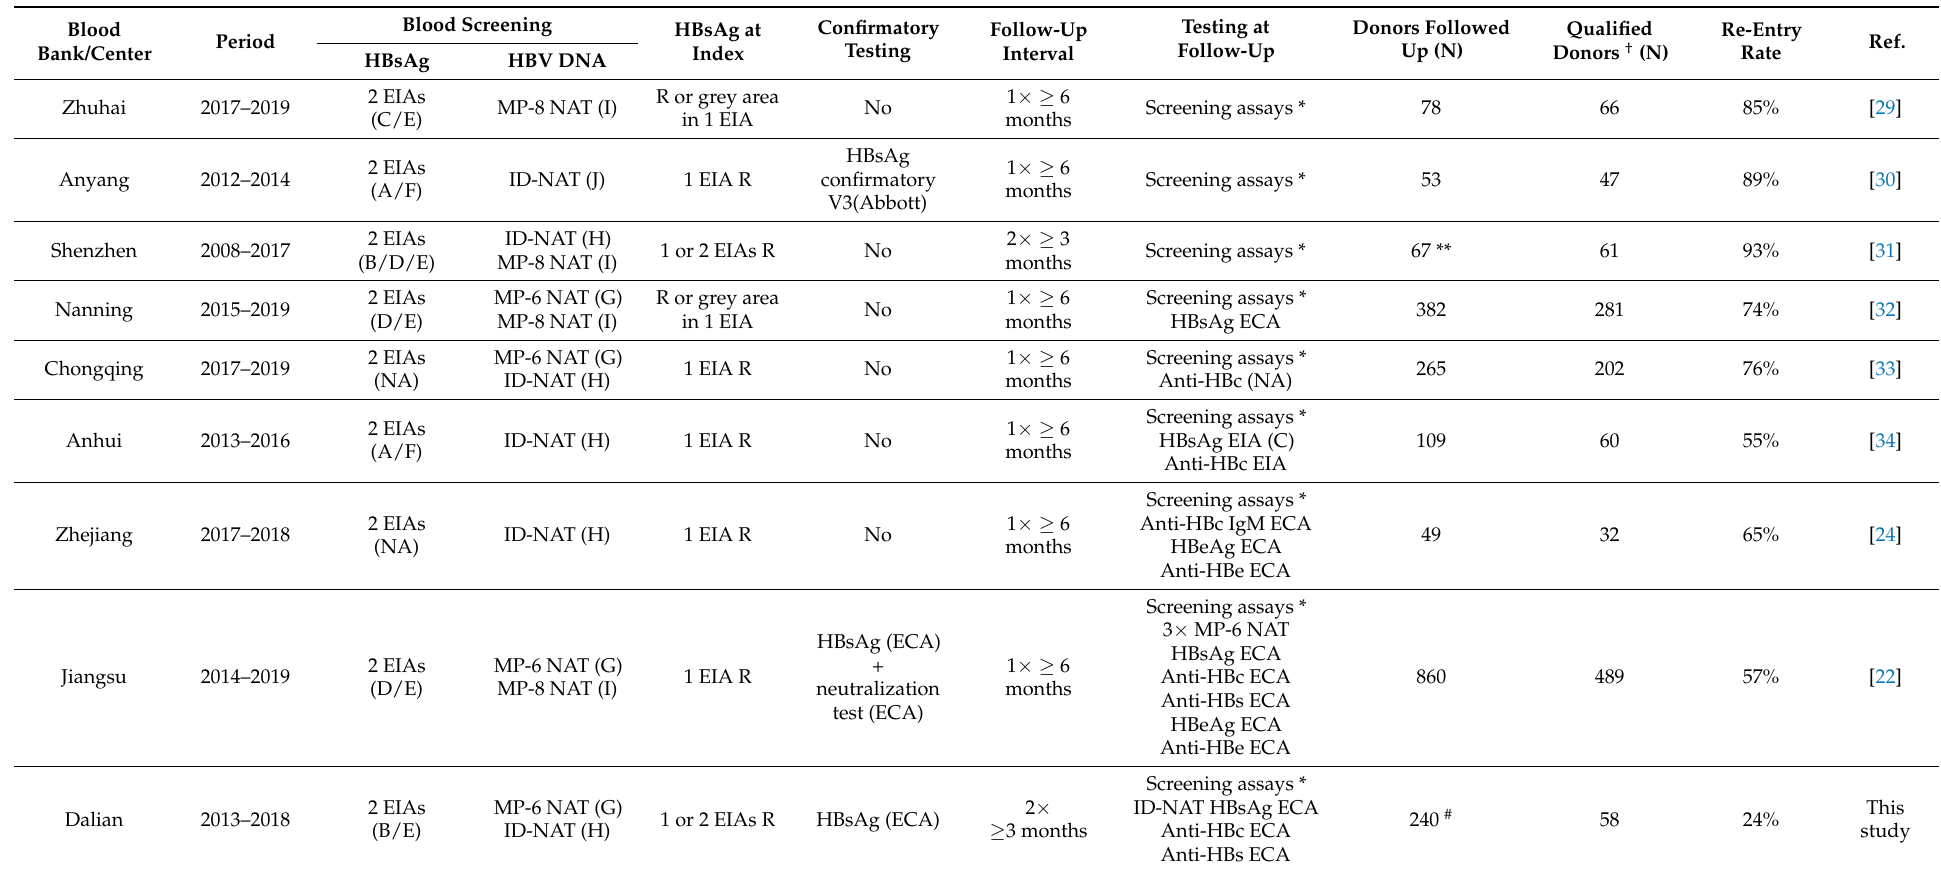
Table 2. Re-entry of blood donors HBsAg reactive and NAT